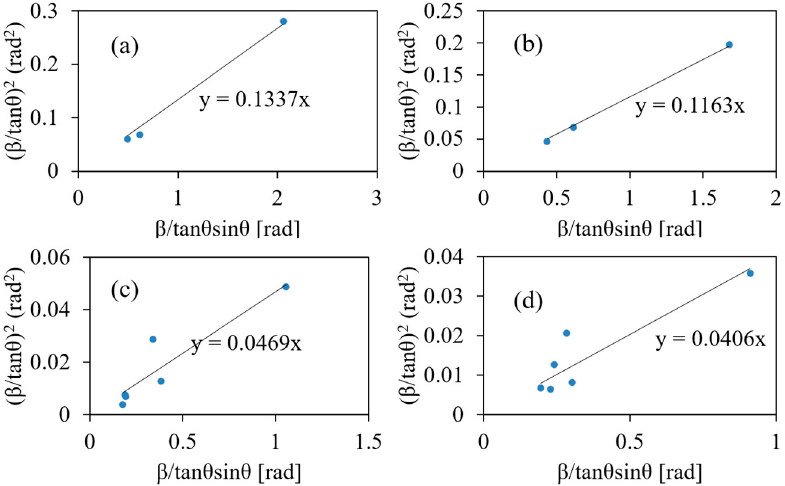
Figure 2. Halder–Wanger plot of the ZrO 2 nanoparticles synthesized at ( a ) 250 °C, ( b ) 300 °C, ( c ) 350 °C, and ( d ) 400 °C obtained using Equation (2).